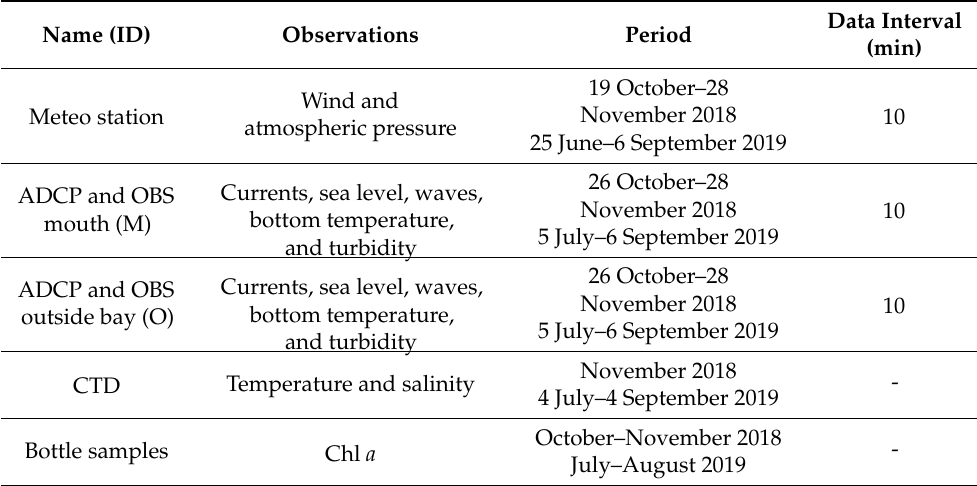
Table 1. Data acquisition instruments and observational periods (years 2018–2019) shown in Figure